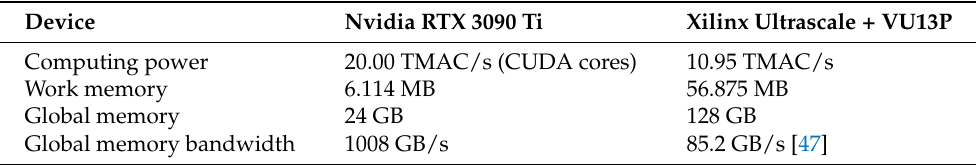
Table 1. Selected devices with their computing power, work memory and data